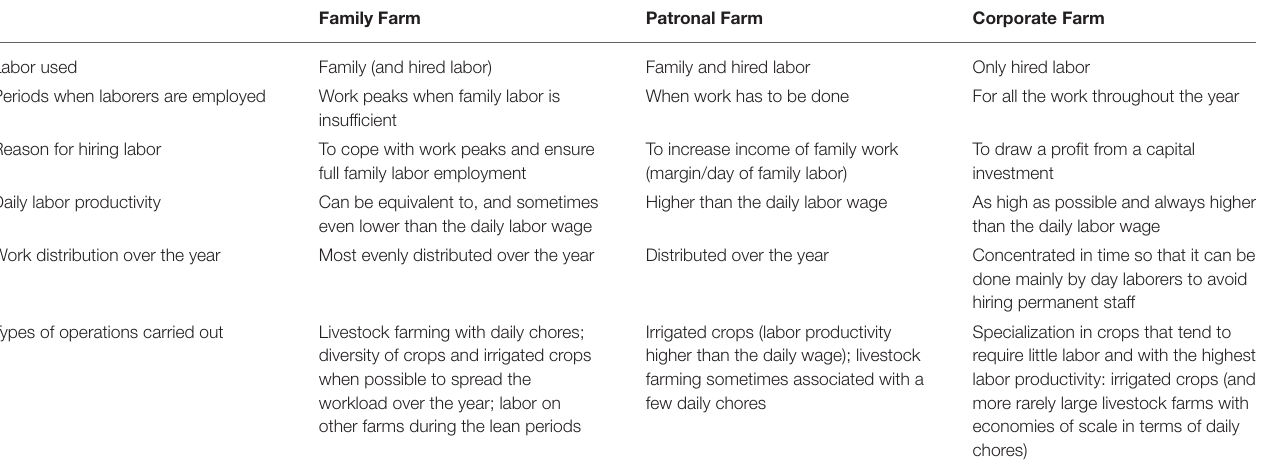
TABLE 3 | Main features of family, patronal and corporate Indian farming